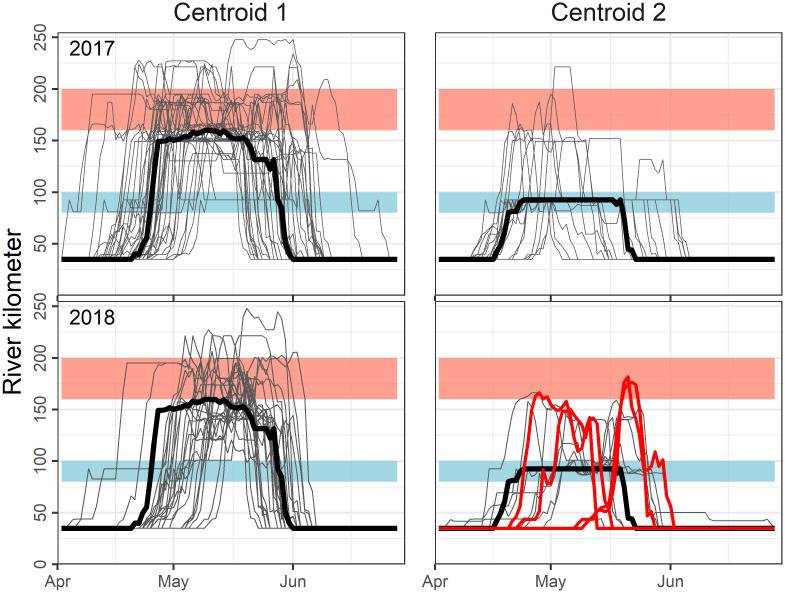
Dynamic time warping centroid identification of Hudson River spawning run contingents.Centroids are fitted to 2017 spawning run behaviors in both 2017 and 2018 (bold black lines; note centroid phenology is duplicated for both years). Individual phenologies are shown as gray and red lines, the latter indicating mis-classified individuals. Colored rectangles identify the river kilometers of the upper (red) and lower (blue) reaches.